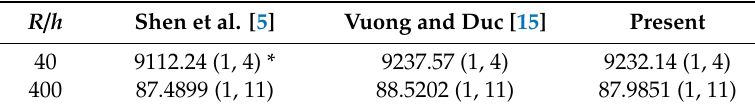
Table 1. Comparison of the upper critical buckling pressure (kPa) for an isotropic cylindrical shell under external pressure and previous results ( L =